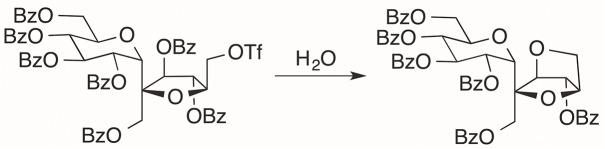
Internal conversion product of protected precursor.